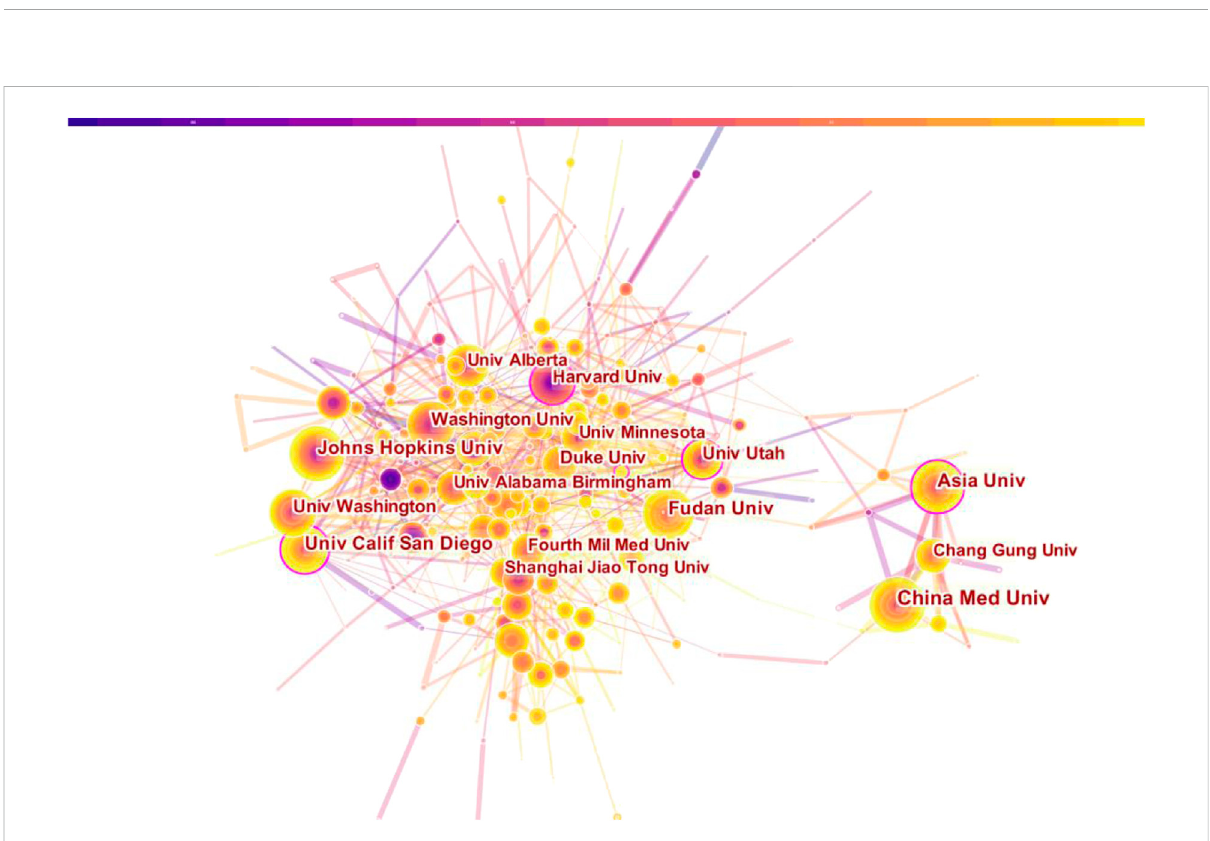
FIGURE 5 Distribution of publications from different